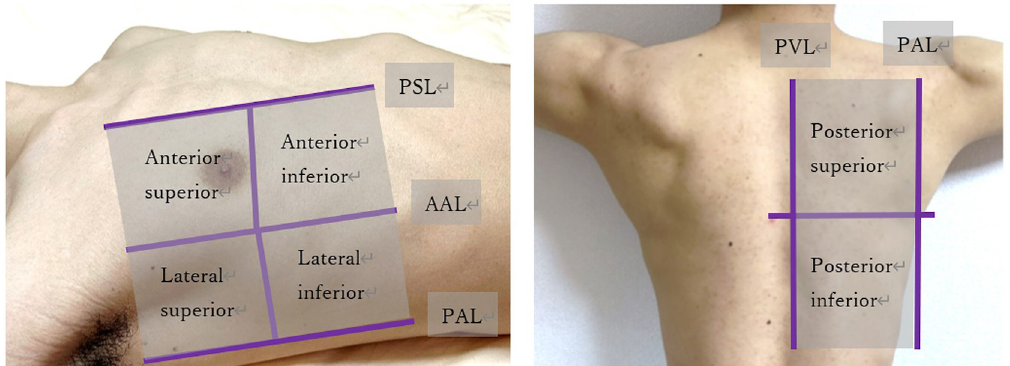
Fig 1. Lung segmentations in 12-zone lung POCUS. The chest was divided into eight zones for the ventral wall and four zones for the dorsal chest wall, divided by the posterior axillary line (PAL). The parasternal line (PSL) and paravertebral line (PVL) to two hemithorax. The ventral chest wall was segmented by the midline and anterior axillary lines (AAL) and further divided into upper and lower zones. The dorsal chest wall was divided into left-right and upper-lower zones at the height of the tip of the